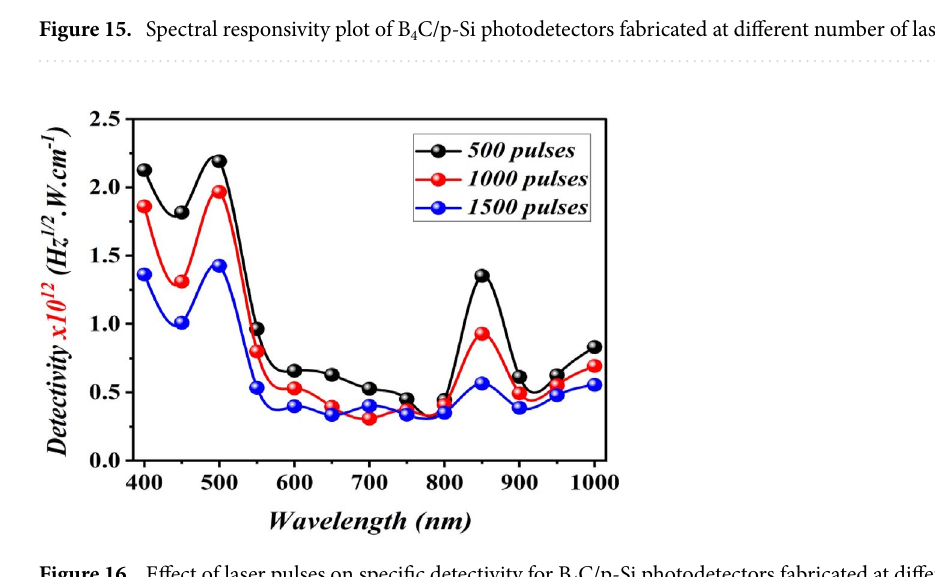
Figure 16. Effect of laser pulses on specific detectivity for B 4 C/p-Si photodetectors fabricated at different number of laser